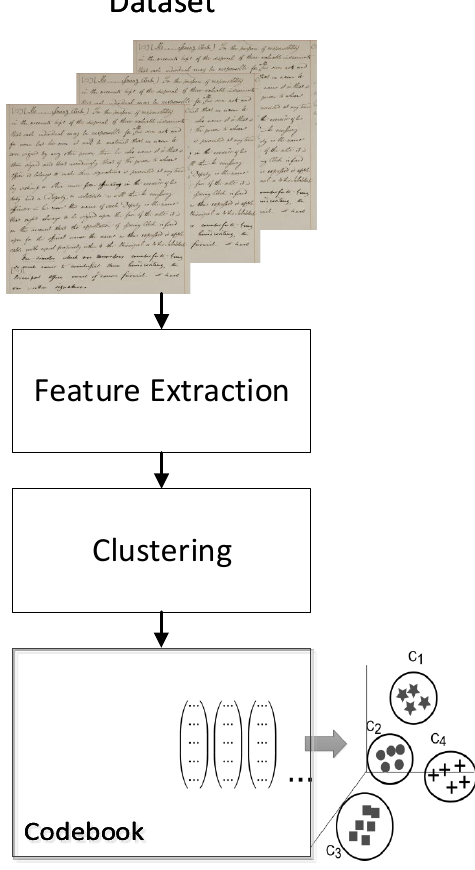
Figure 6. The overall architecture for the quantization of the DoLF descriptors using multiple Bag of Visual